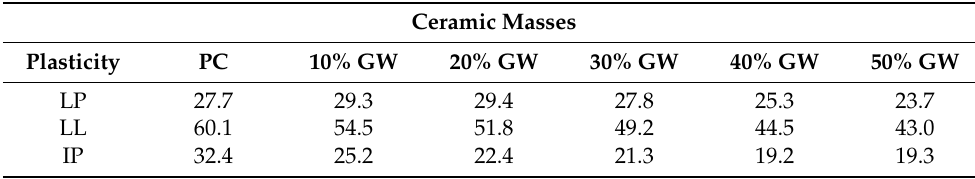
Table 3. Atterberg limits of ceramic